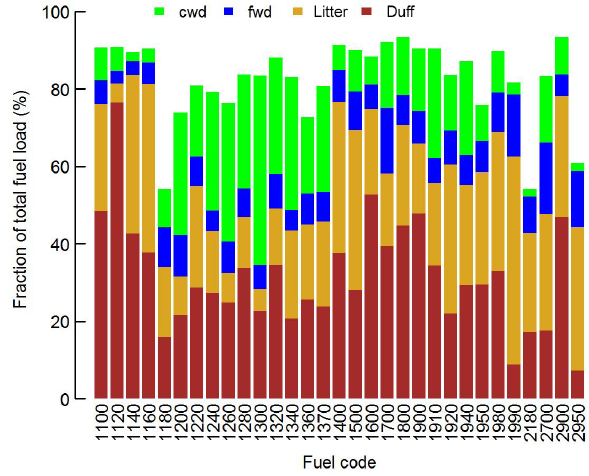
Figure 6. Fraction of best-estimate (Table 4) total forest fuel load- ing in surface fuel loading groups by fuel type.